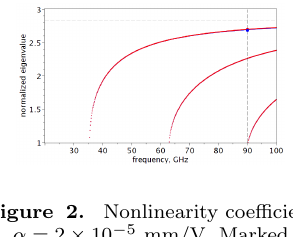
Figure 3. Nonlinearity coefficient α = 2 × 10 − 5 mm/V. Eigenfunctions. Blue dash line (linear problem) β ≈ 5 . 0815 and red line (nonlinear problem) β ≈ 5 . 0893.